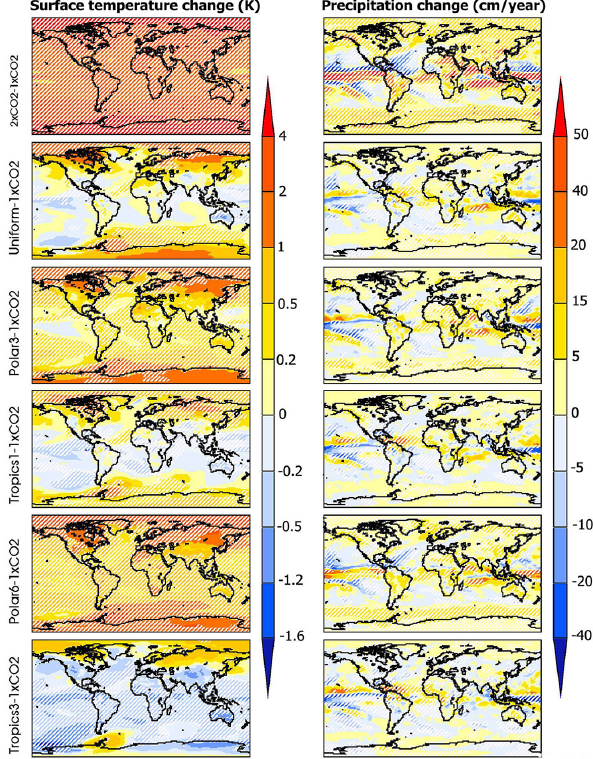
Figure 9. Changes in annual-mean surface temperature (left pan- els) and precipitation (right panels) in the 2 × CO 2 , Uniform, and some Polar and Tropics geoengineering scenarios relative to the control (1 × CO 2 ). Hatching indicates the region where the changes are significant at 1% level. Significance level was estimated using Student’s t test. Both surface temperature and precipitation changes are large and significant everywhere in the 2 × CO 2 and extreme scenarios (Polar6 and Tropics3). Although significant over large re- gions, both temperature and precipitation changes are small in the Uniform case. Polar3 scenario offsets global mean precipitation but not global mean temperature while Tropics1 scenario offsets global mean temperature but with reduced precipitation. Results shown are averages of the last 30 years of 60-year